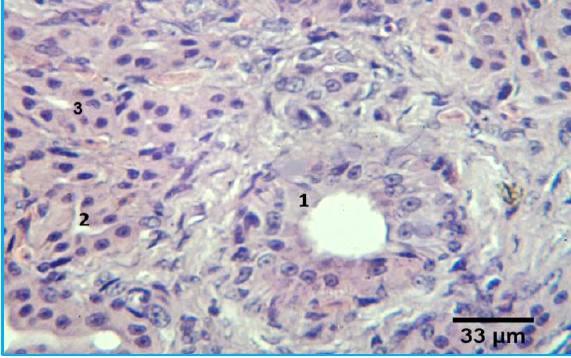
Figure, 8: Transverse section salt glands shows: striated duct (1), intercalated duct secretory unite (3). (H and E)